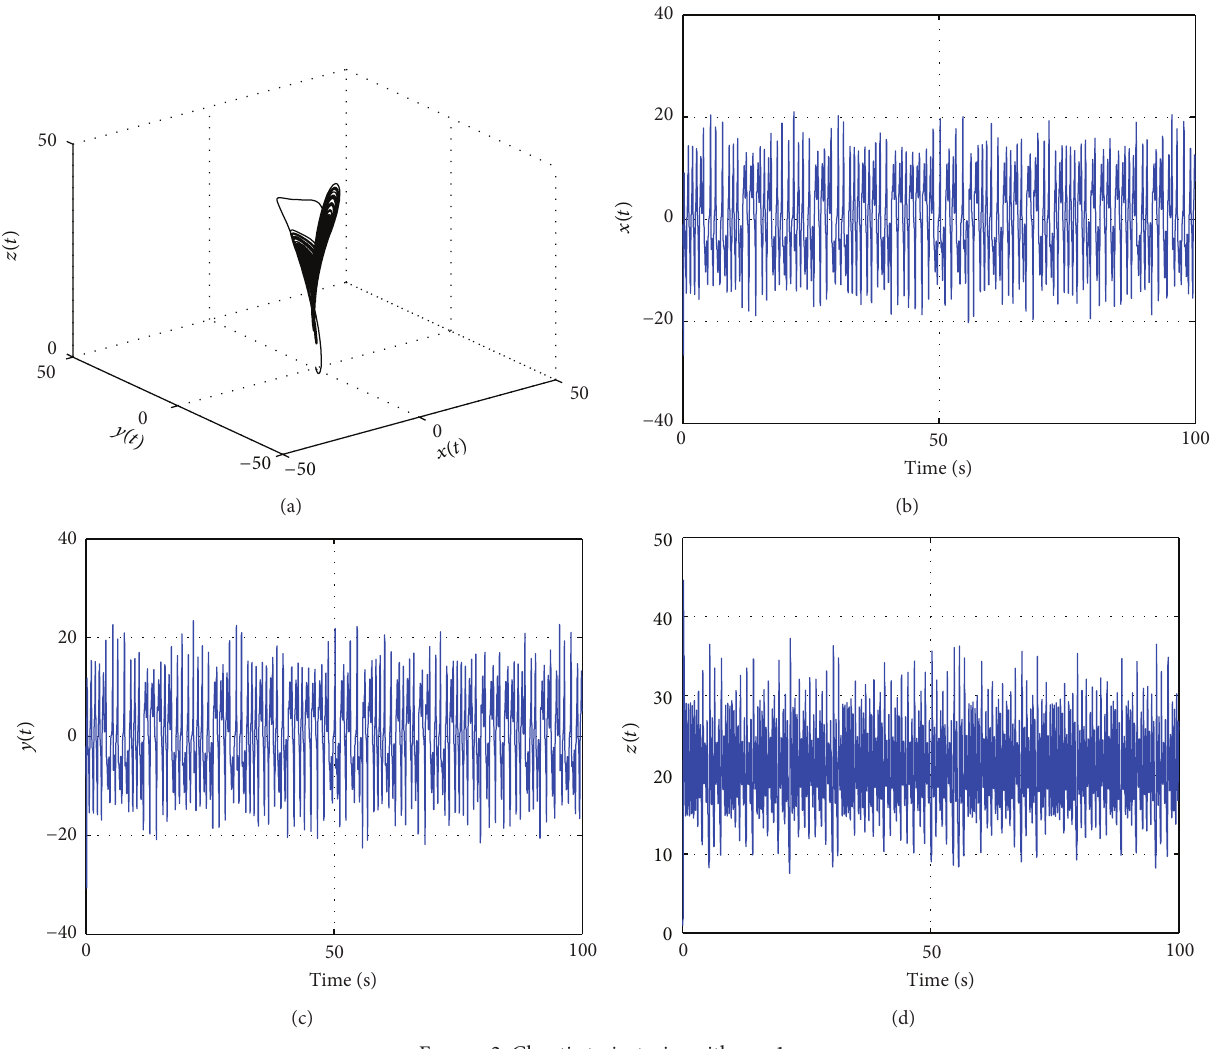
Figure 2: Chaotic trajectories with 𝛼 = 1